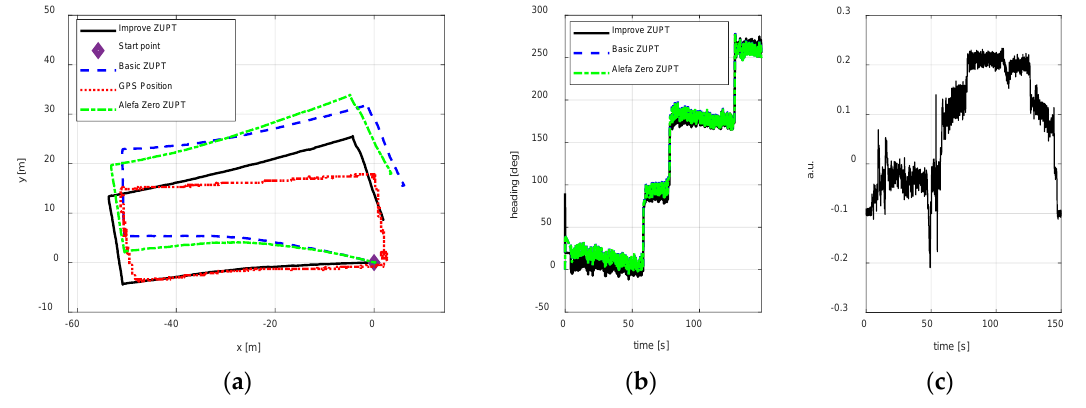
Figure 10. A rectangle path position result. ( a ) Trajectory; ( b ) Heading estimation result; ( c ) Magnetometer disturbances.